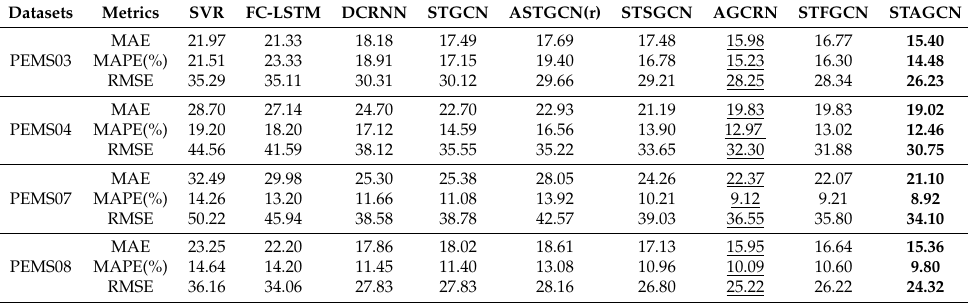
Table 2. Performance comparison of different methods on PEMS datasets. Datasets